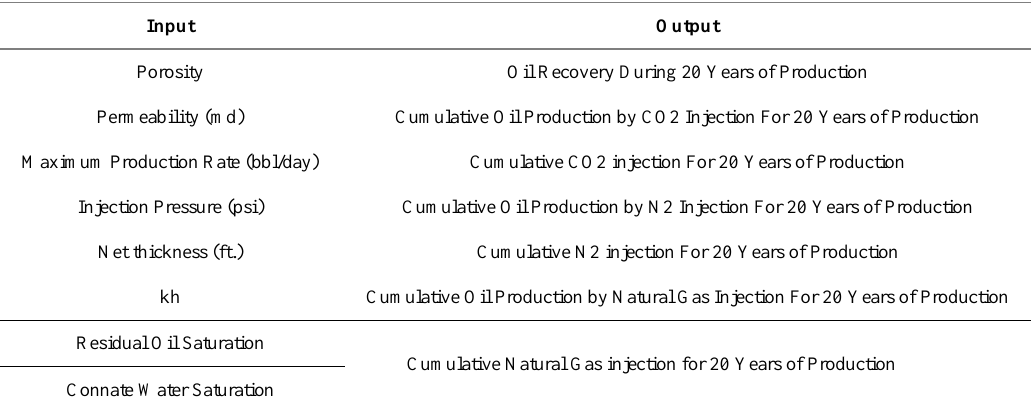
Table 9. Inputs and outputs for designing neural networks in Neuro-Simulation